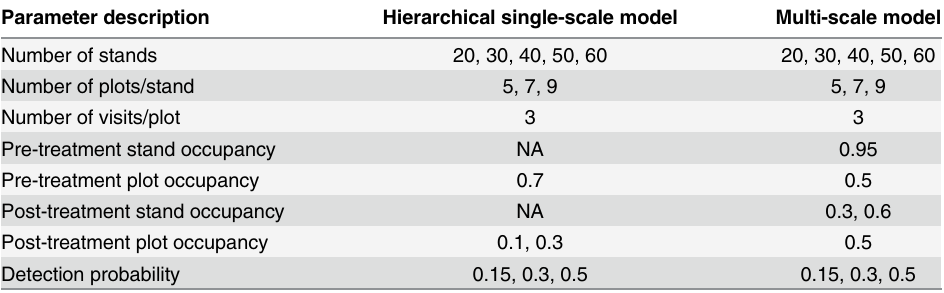
Table 1. Parameters used to simulate data under the hierarchical single-scale and multi-scale occu- pancy